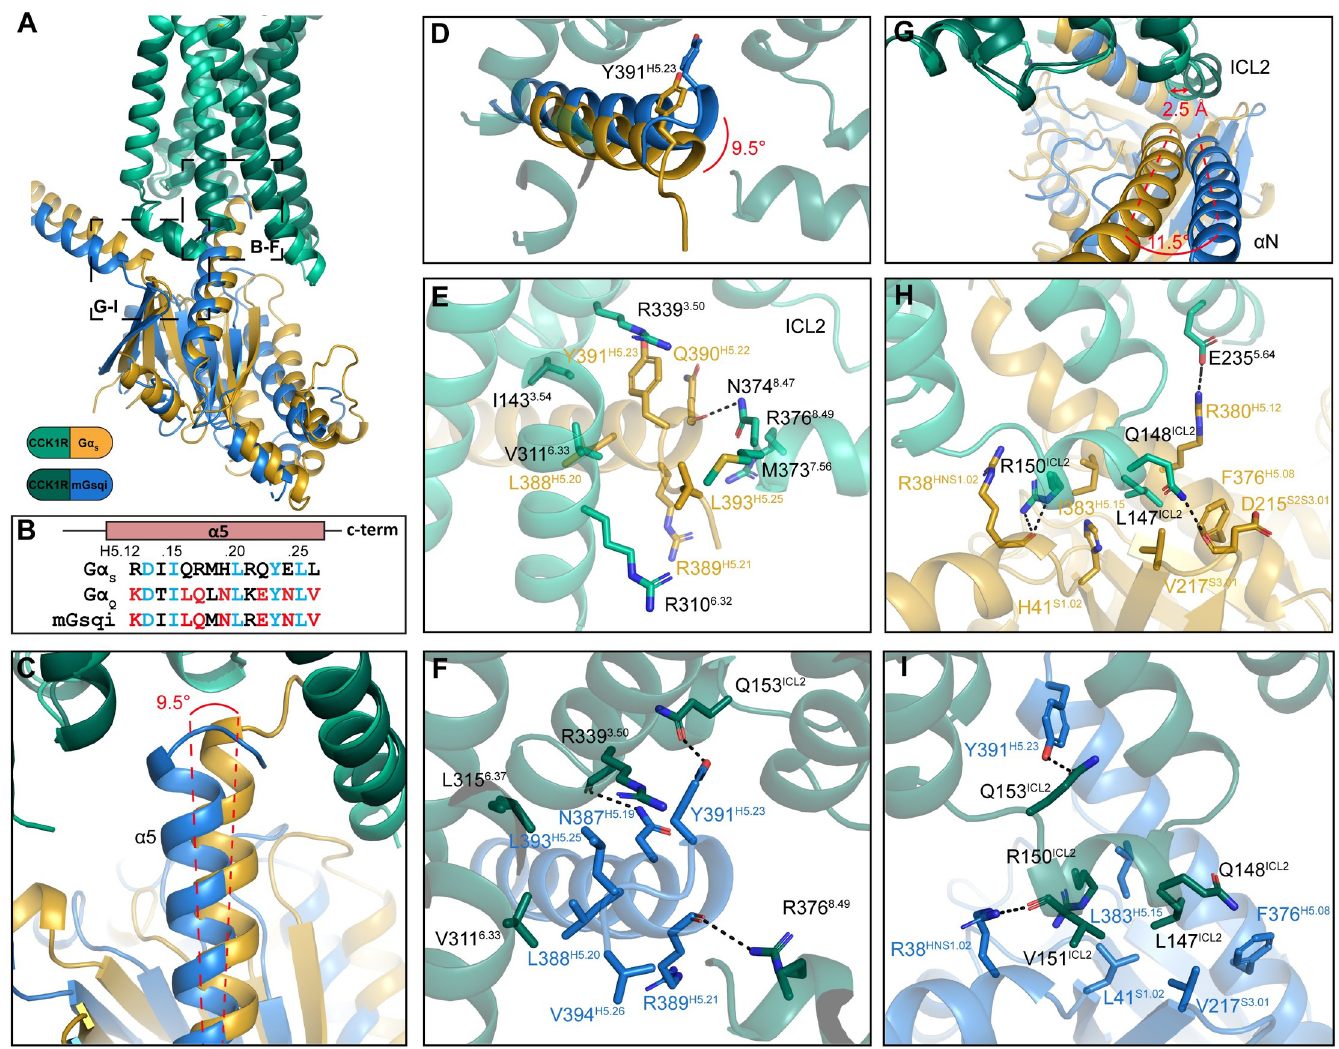
Fig 3. G protein interactions with activated CCK1R. ( A ) Overlay of G α subunits bound to the CCK1R highlighting the position of the magnified section in panels B– G. ( B ) The sequences of the G α carboxyl terminus ( α H5) for G α s, G α q, or the chimeric mG α sqi protein. Residues common to both parental G proteins are coloured light blue, amino acids unique to Gs are coloured black, and those of Gq are coloured red. ( C , D ) There is an approximately 9.5-degree difference in the position of the carboxyl terminus of the 2 G proteins relative to the origin of the α H5. ( E, F, H, I ) G α s protein ( E, H ) and the G α q-mimetic protein ( F, I ) form distinct interactions with CCK1R, illustrated from the top of the α H5 ( E, F ) or the junction of the α N and α 5 helices that interacts with ICL2 of the CCK1R ( H, I ). Protein backbone is illustrated in ribbon format with G α s in gold (CCK1R, light green) and mG α sqi in blue (CCK1R, dark green). Side chains from the G protein or receptor that interact are displayed in stick format, coloured by heteroatom. Dashed lines indicate H-bonds. G protein residues are numbered according to the CGN G protein numbering system [38]. α H5, α 5 helix; CCK, cholecystokinin; CCK1R, cholecystokinin type 1